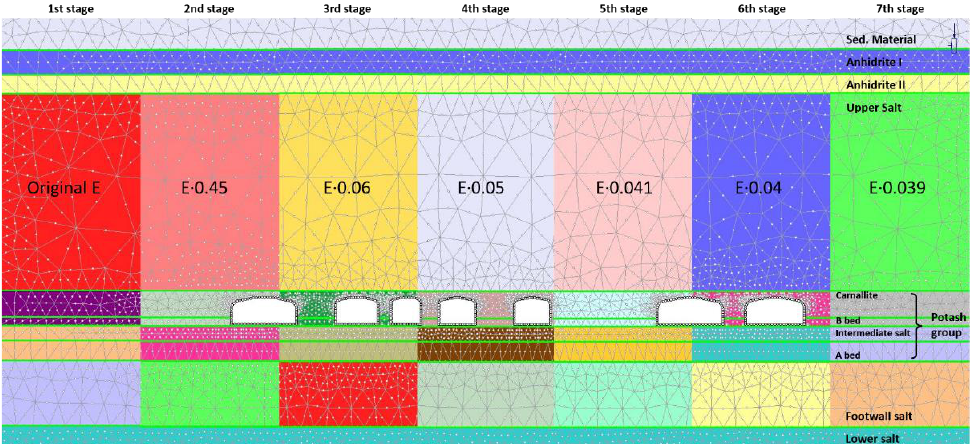
Figure 5. Example of the seven stages and their associated Young’s modulus (E).